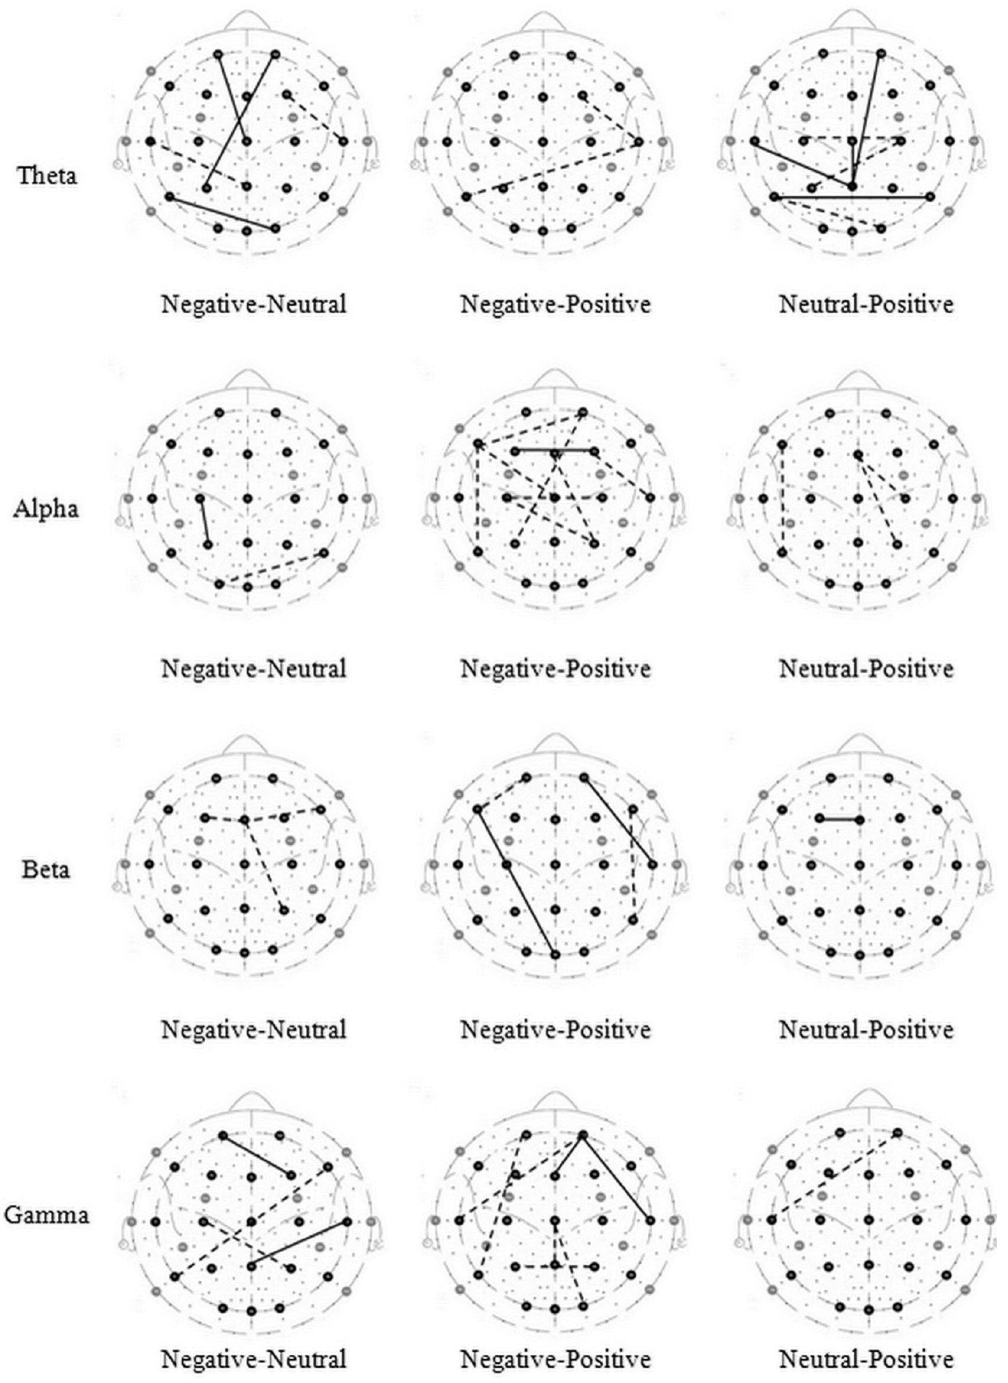
Figure 3. Brain maps of phase synchronization index. The lines connecting electrode sites indicate significant higher (solid) and lower (dashed) of phase synchronization index for condition listed on left site.